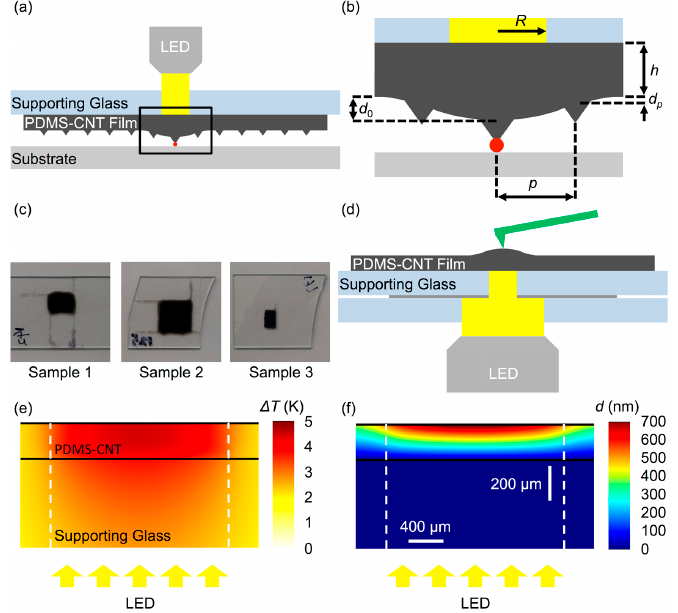
Figure 1. Schematics of ( a ) working principle of polydimethylsiloxane ‐ carbon nanotube (PDMS–CNT) ‐ based photoactuated polymer pen lithography (PPL). When illuminated, the desired pen deformed out ‐ of ‐ plane, to come into contact with the substrate and transfer ink. ( b ) Critical geometric factors of a photoactuated PPL pen array, including illumination radius 𝑅 , elastomer film